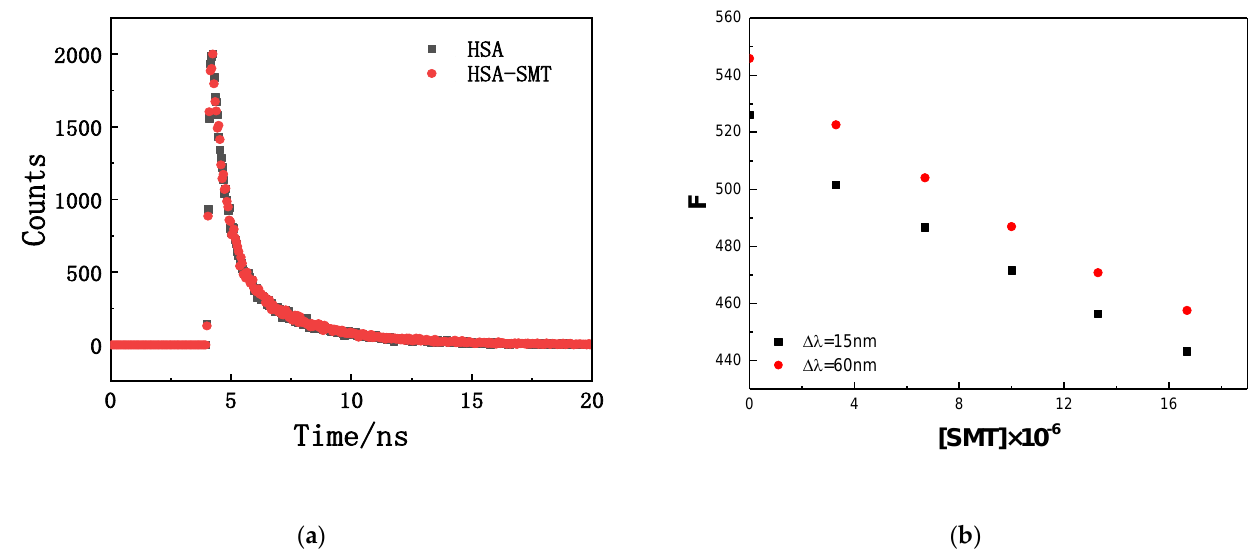
Figure 2. ( a ) Fluorescence decay curve of HSA in the absence and presence of SMT. C HSA = C SMT = 3.3 × 10 −6 mol·L −1 . ( b ) Fluorescence intensity corresponding to different SMT concentrations.